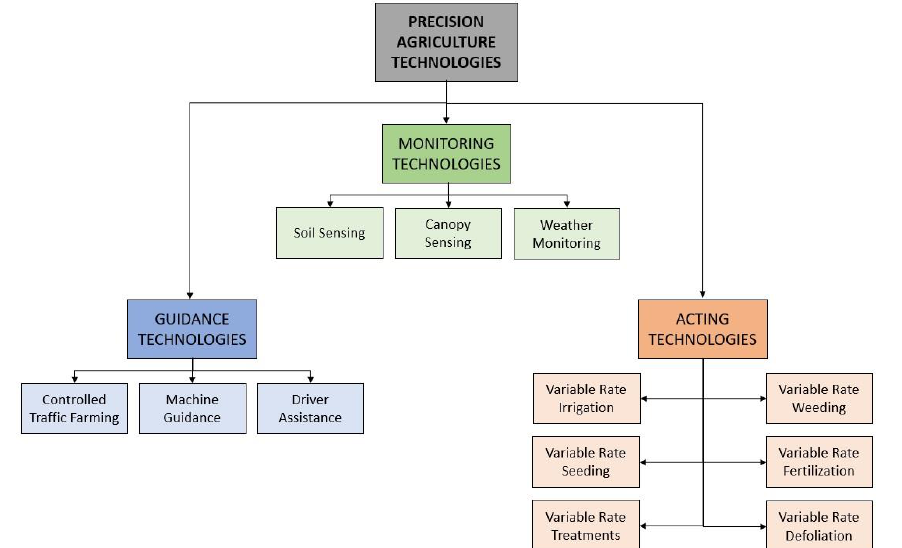
Figure 2. Precision agriculture technologies overview (adapted from [11], with permission from Sustainability , 2017).